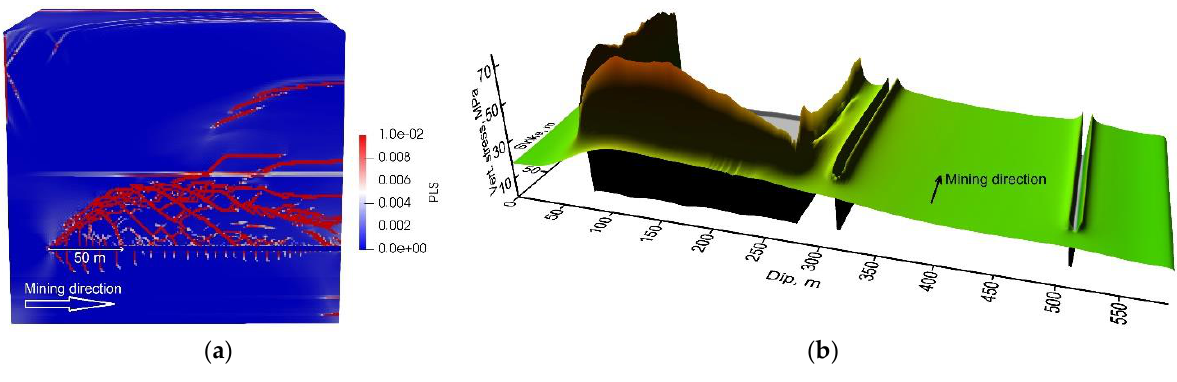
Figure 6. Distribution of inelastic strain in vertical cross-section of the model in plane close to roadway I ( a ); resultant σ yy distribution in the seam 3 plane ( b ).